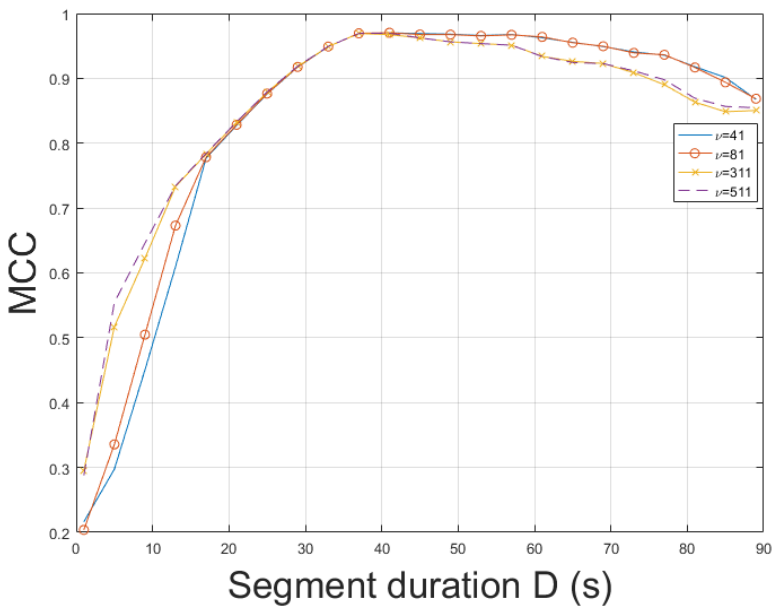
Figure 5. Maximum correlation coefficient of the proposed approach employing SLIC+STFT for various bandpass filter orders and segment durations